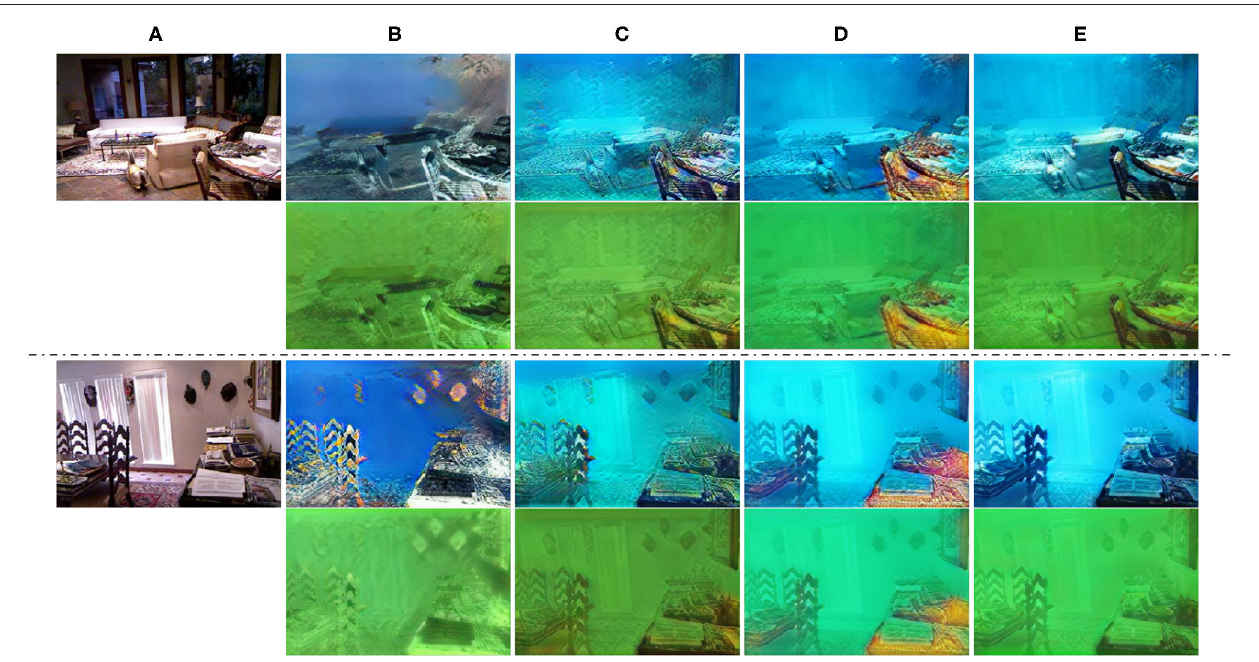
FIGURE 6 | Sample results of our method for synthesizing underwater images using different losses. L ssim , L msssim and L syn , respectively represent SSIM loss, MS-SSIM loss, and perceptual loss. (A) Are in-air images, (B) are the results without any structural loss (Baseline), (C–E) are the results with L ssim , L msssim , and L syn , respectively.